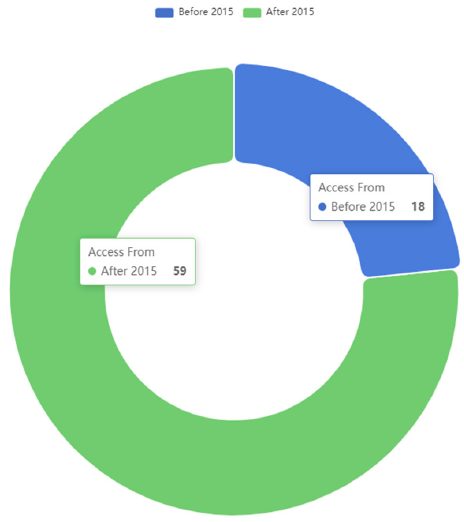
Figure 1. Number of publications before and after 2015.